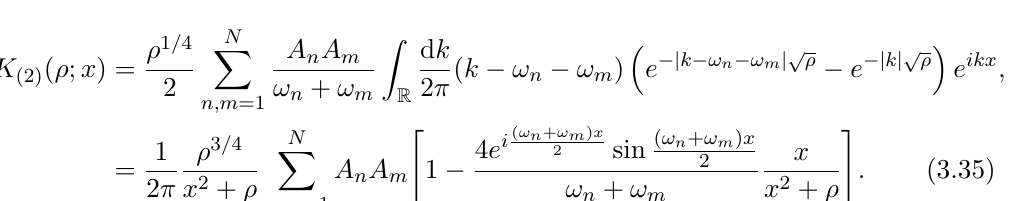
Figure 3 . Expectation value of the boundary operator O eq. (3.33) for source s ( x ) = cos and discrete implementation of a disordered geometry g ( x ) = amplitudes of